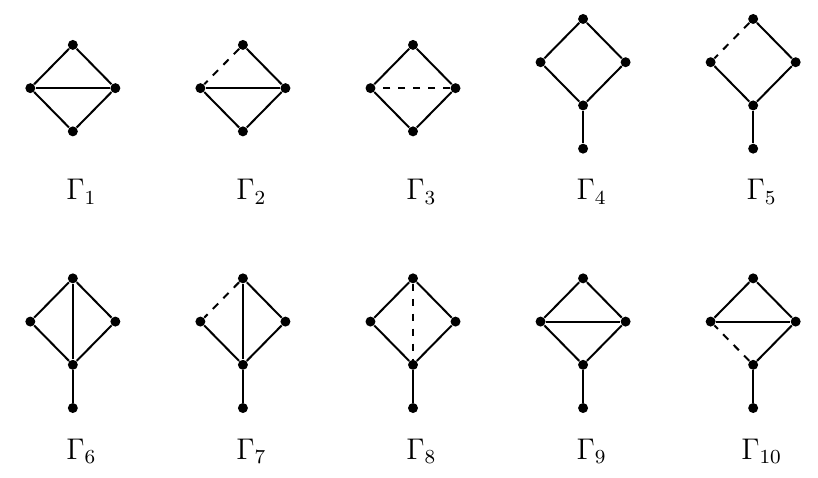
Fig. 2: Signed graphs Γ with θ ( Γ ) ⩽ 3 and circumference c ⩾ 4 . Dashed lines represent negative